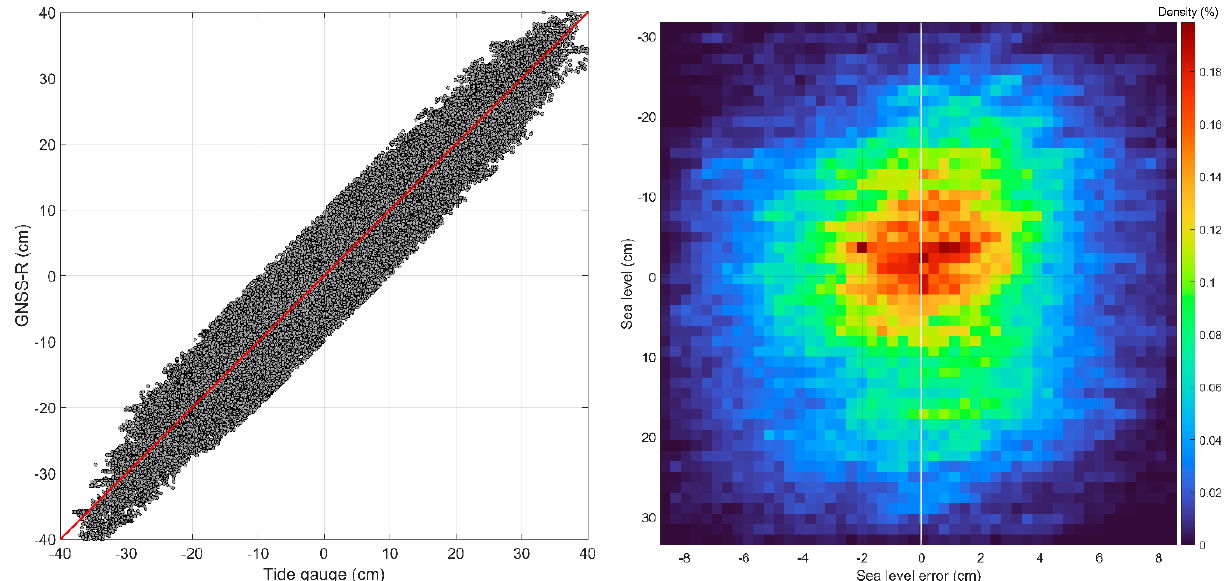
Figure 6. Scatterplot of sea levels shows an excellent agreement between OTT RLS records and GNSS-R sea level retrievals (left panel). Van de Casteele diagram shows no systematic errors between the two sensors at the Port-au-Prince tide gauge station (right panel).